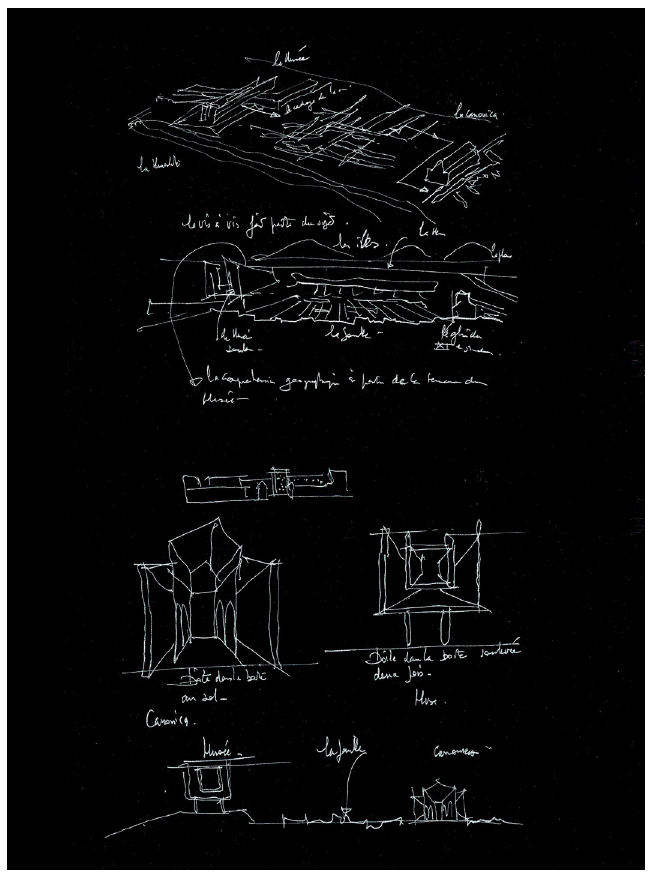
Fig. 7 Pierre-Louis Faloci, Archaeological Museum of Mariana , project sketches (Biagi,